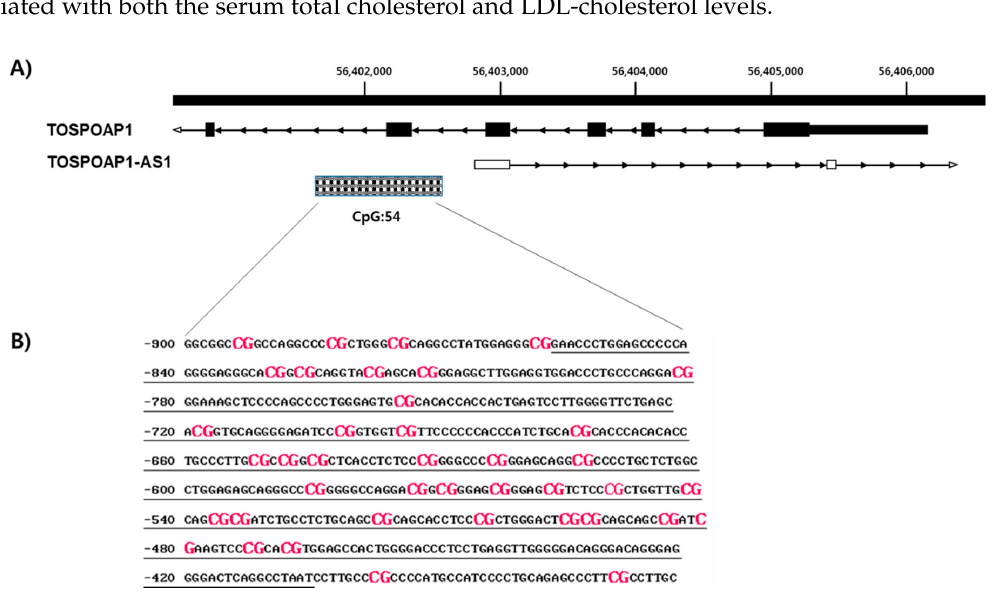
Figure 2. TSPOAP1-AS1 methylation associated with obesity. ( A ) Distribution of mean DNA methylation level on normal and overweight/obese subjects. ( B ) Significance of hypermethylation at the specific CpG sites of TSPOAP1-AS1 promoter region in overweight/obese subjects compared to normal subjects.